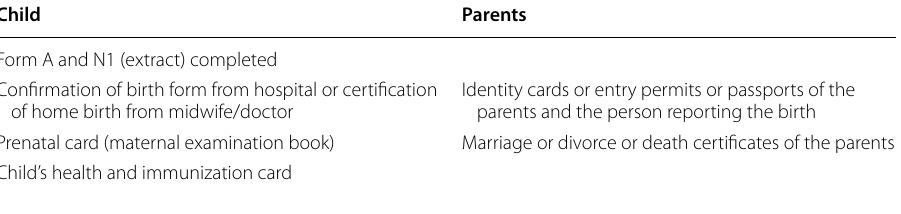
Table 1 Documents required by the National Registration Department for normal registration of birth in